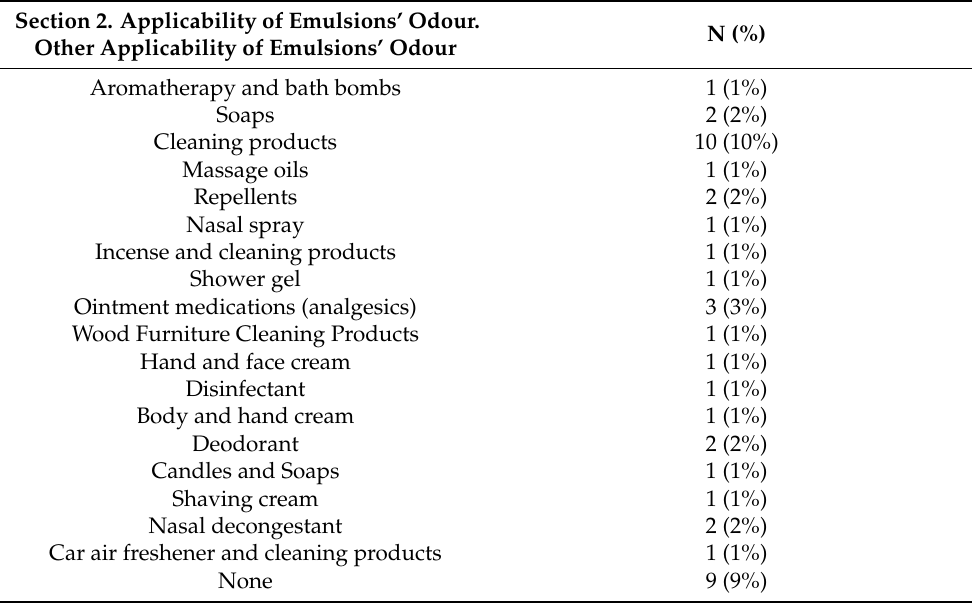
Table 9. Participants responses to other applications of the emulsions’